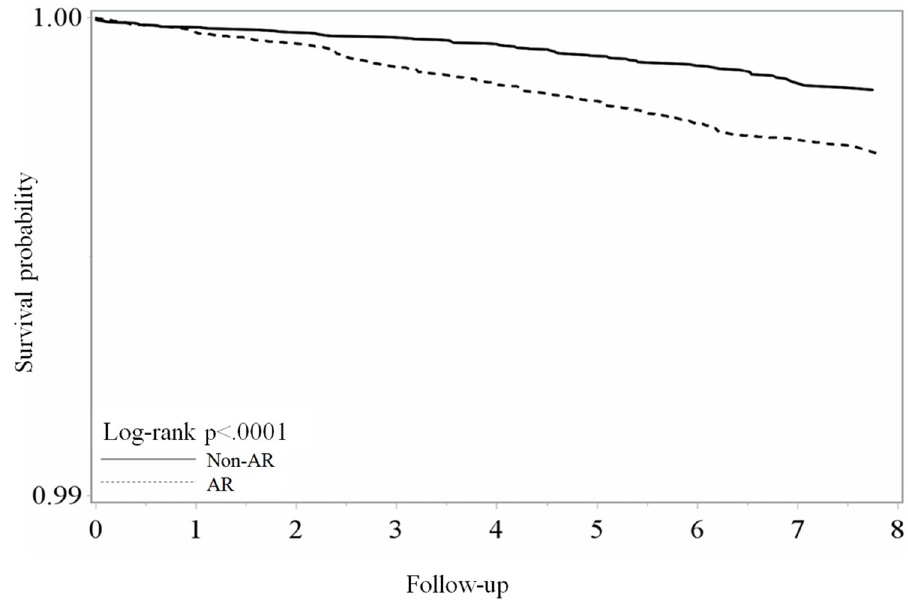
Fig 2. Kaplan-Meier model for estimating dental trauma-free allergic rhinitis patients and non-allergic rhinitis patients.